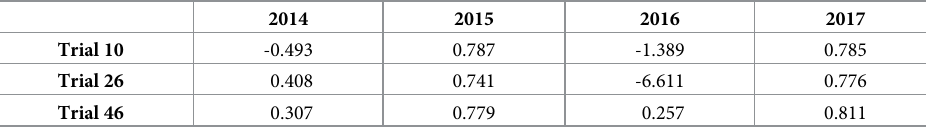
Table 2. R 2 of the simulation over the 2014–2017 period a .